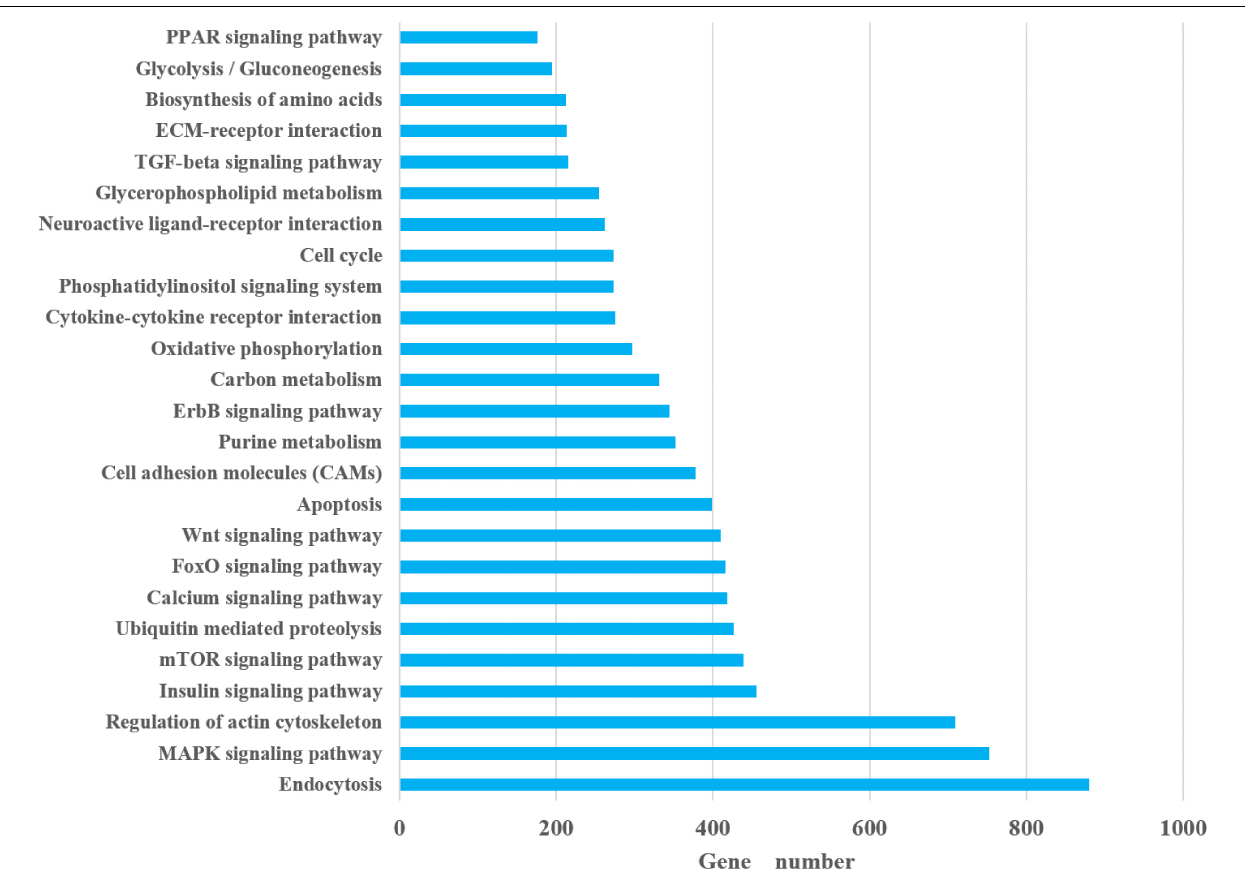
FIGURE 2 | Pathways associated with